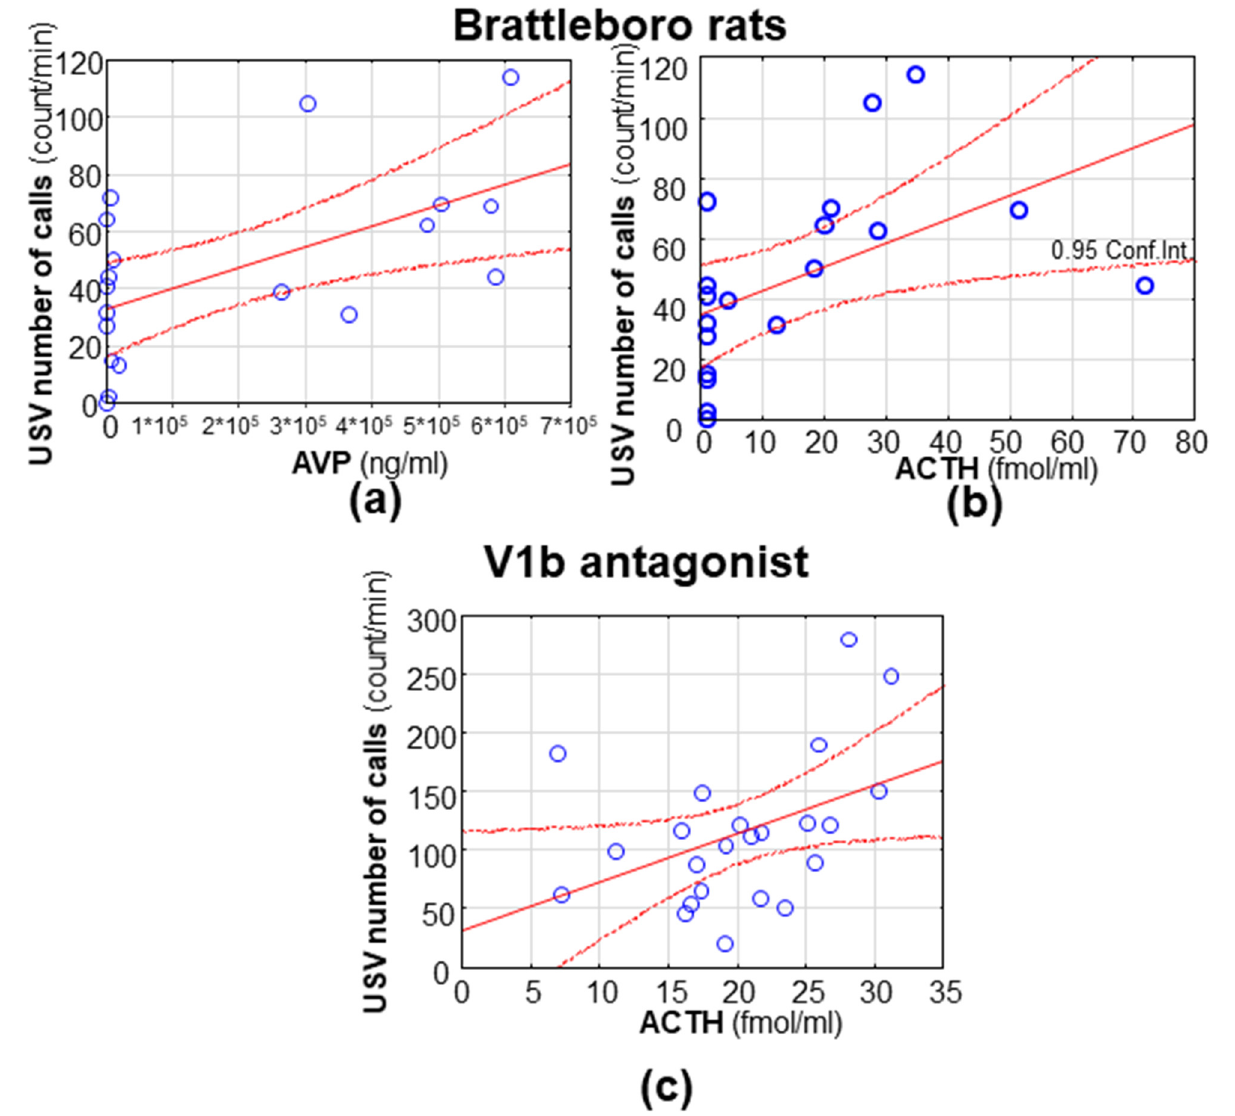
Figure 6. The most important correlations. In Brattleboro pups (both di/+ and di/di genotypes), ( a ) the hypophysis vasopressin (AVP) content positively correlated with the emitted number of ultrasonic vocalizations. A similar positive correlation was observable between the serum ACTH levels and the ultrasonic vocalization number both in ( b ) the Brattleboro pups and ( c ) after a vasopressin (V) 1bR antagonist treatment.